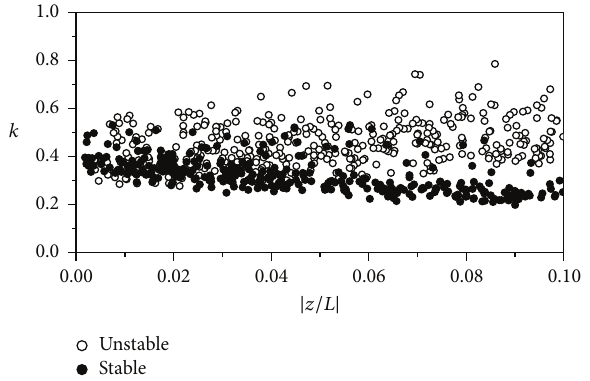
Figure 3: The scatter plot of the von K´arm´an constant ( 𝑘 ) with respect to |𝑧/𝐿| ≤ 0.1 .